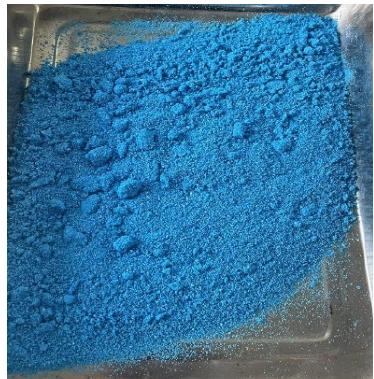
Figure 1. High-viscosity additive.